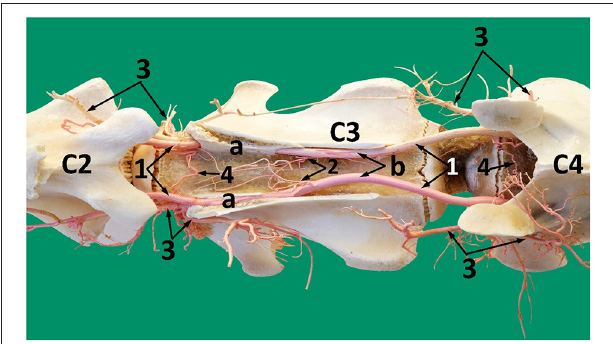
FIGURE 7 | A photograph showing the route of the vertebral artery inside the vertebral canal (dorsal view). 1, vertebral artery; 2, spinal branches of the vertebral artery; 3, ventral and dorsal muscular branches of the vertebral artery, 4, tortuous shunt between the right and the left vertebral arteries; Note: The vertebral artery travels partly through the transverse canal (a) and partly through the vertebral canal (b).